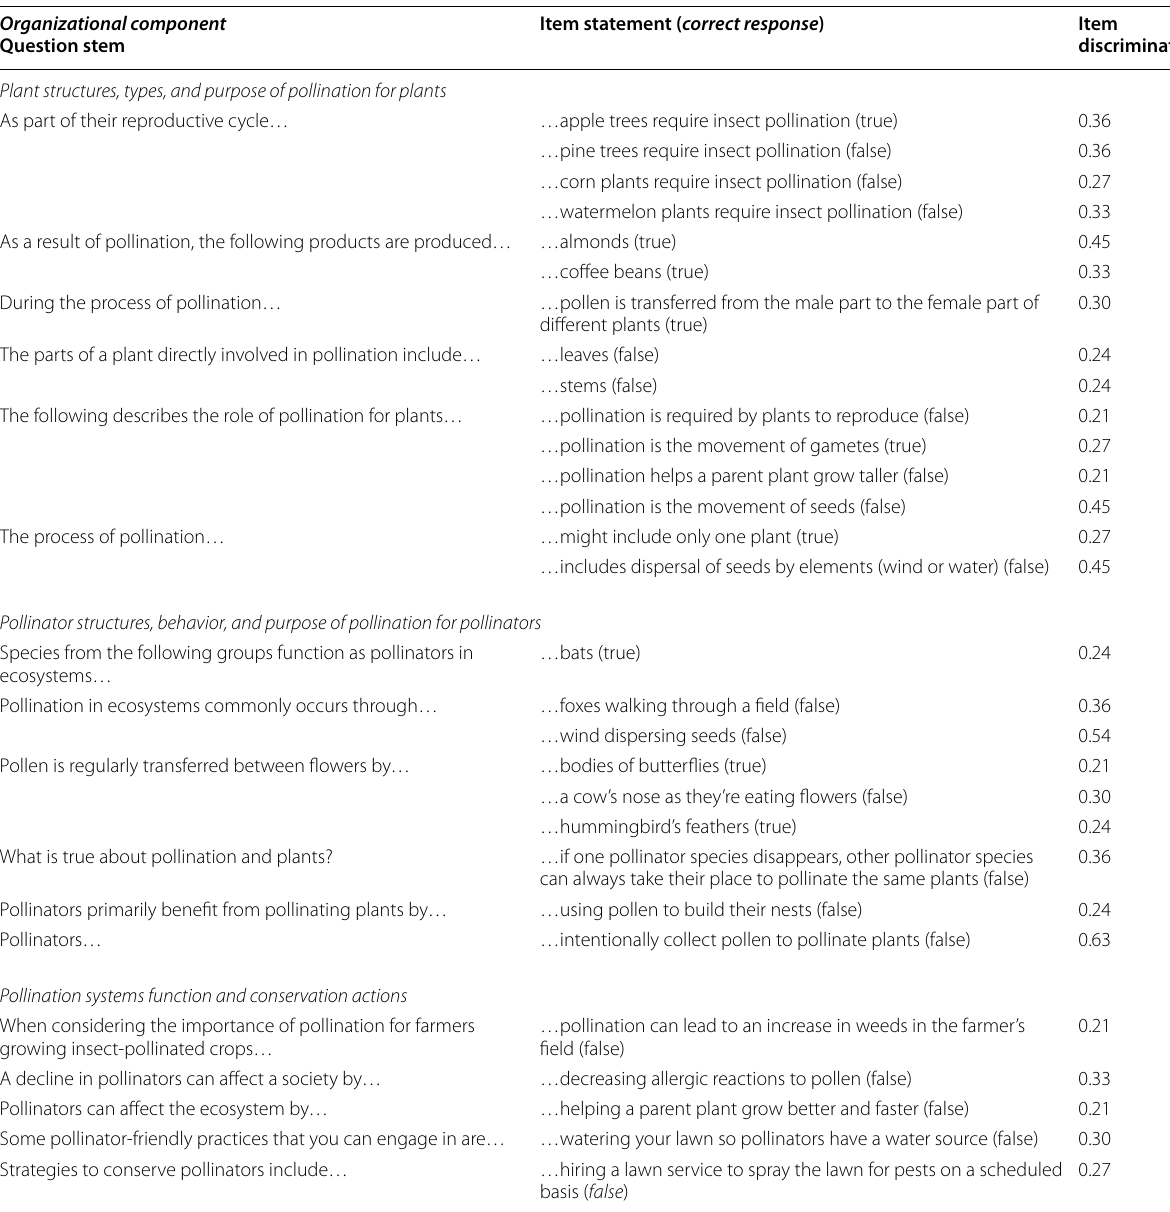
Table 3 List of items from the PSKA with high discrimination values (greater than 0.2) during Spring 2019 within each component from Golick et al.’s (2018)